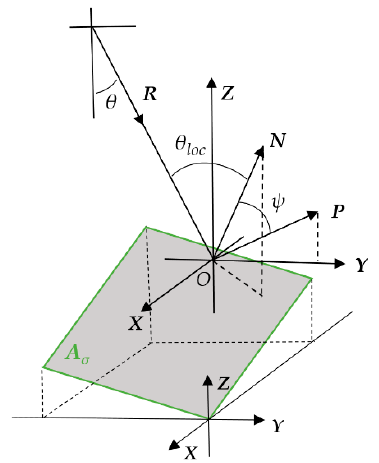
Figure 4. Local geometry of SAR imaging. R , X , and Y are the vectors of incident wave direction, azimuth direction, and range direction, respectively. N is the surface normal and P is perpendicular to R in the incidence plane. ψ is the projection angle, θ loc is the local incidence angle, and θ is the incidence angle of a horizontal surface patch.